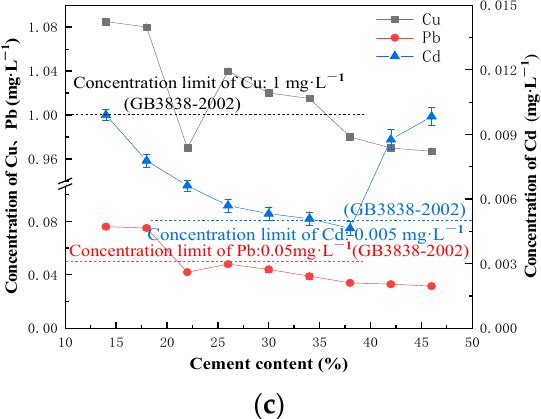
Figure 2. ( a ) Heavy metal leaching concentration with different water content; ( b ) Heavy metal leaching concentration with different organic matter content; and ( c ) Heavy metal leaching concentration with different cement content.